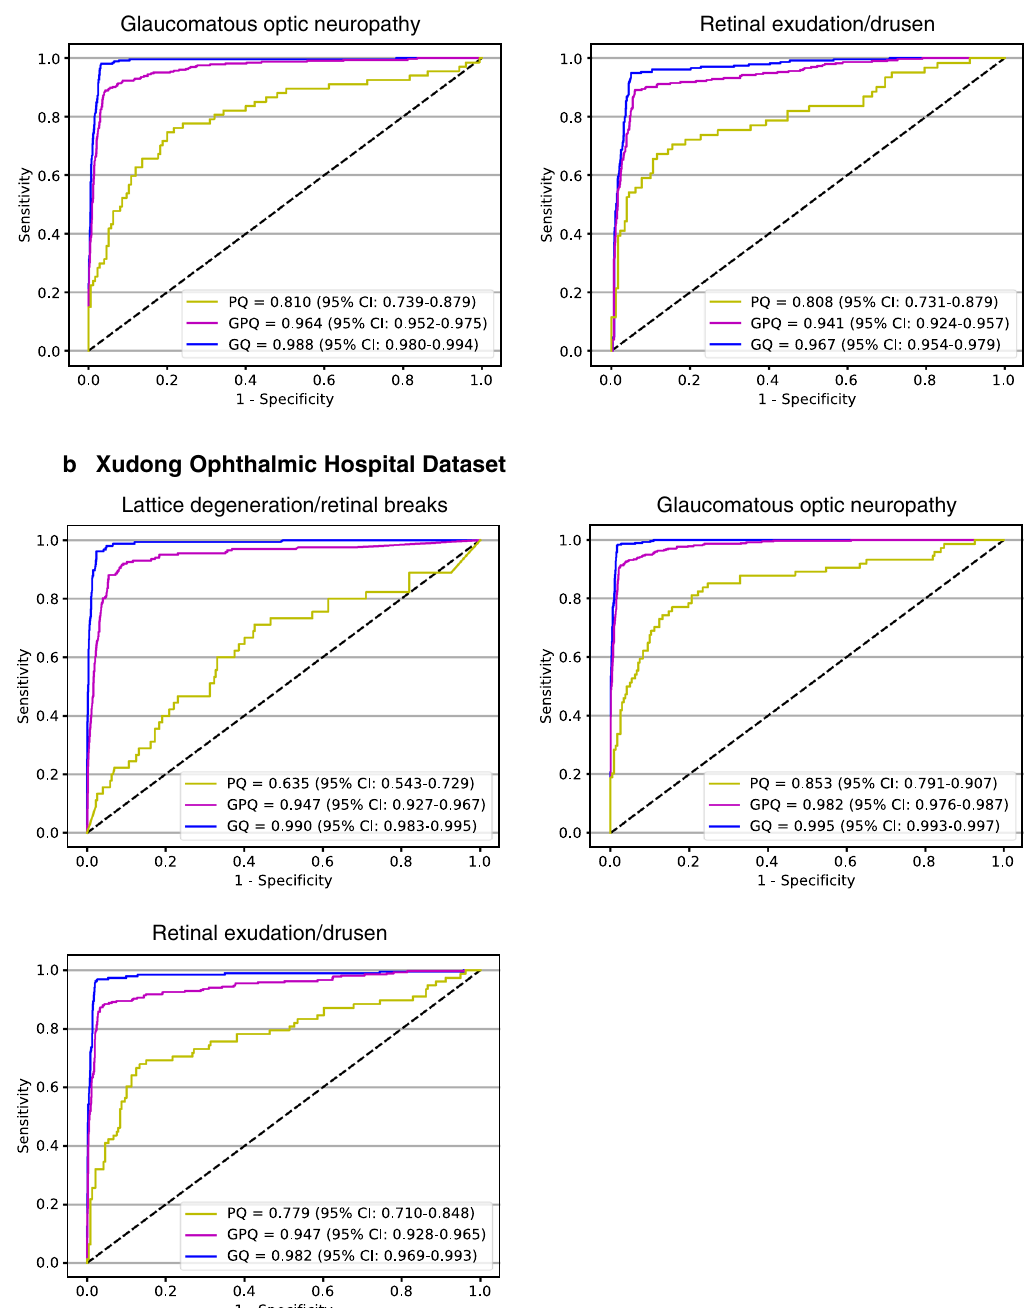
Fig. 4 Performances of established AI diagnostic systems in images with different quality levels. Receiver operating characteristic curves of previously established AI diagnostic systems for detecting lattice degeneration/retinal breaks, glaucomatous optic neuropathy, and retinal exudation/drusen in images of only good quality (GQ), only poor quality (PQ) and of both good and poor quality (GPQ), respectively. The images were obtained from the Zhongshan Ophthalmic Centre and Xudong Ophthalmic Hospital datasets. AI arti fi cial